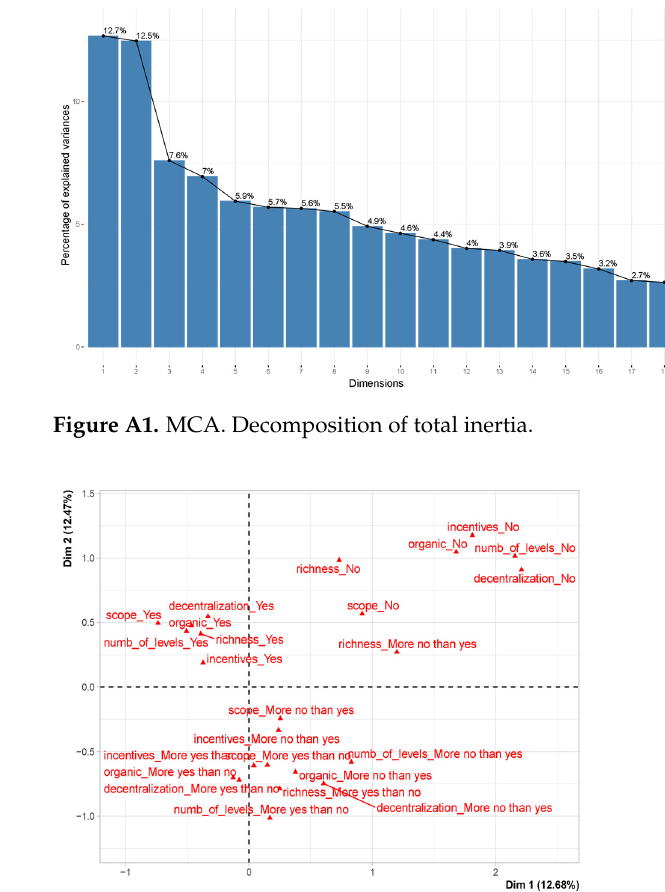
Figure A2. MCA. Active categories.